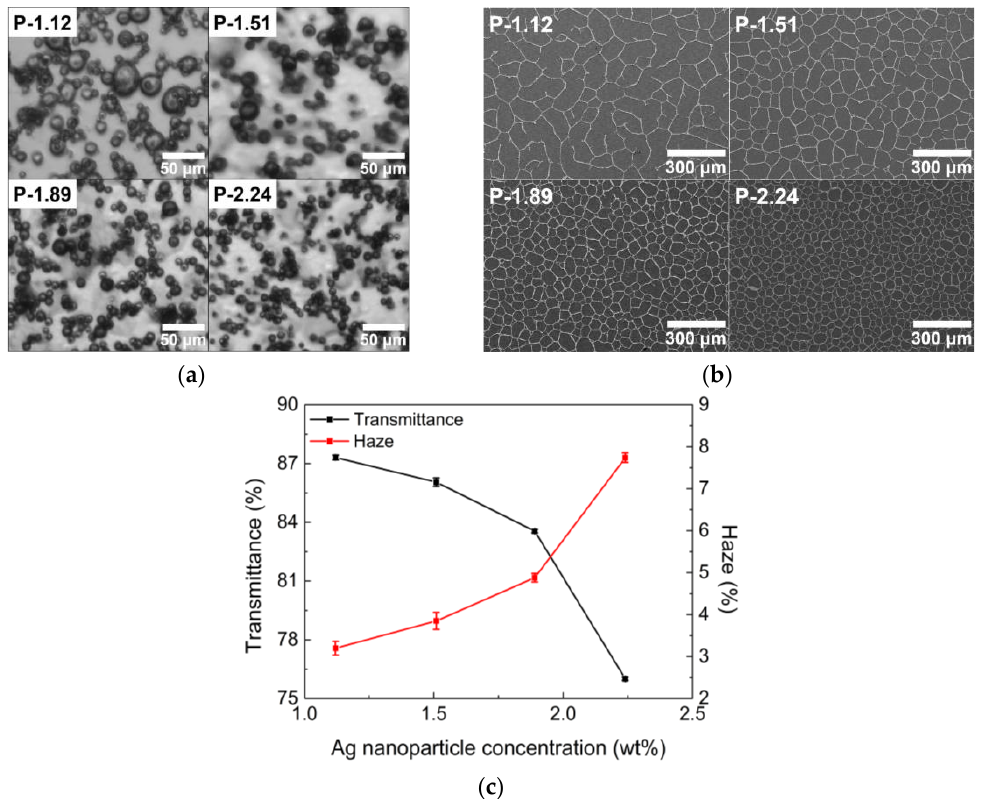
Figure 2. ( a ) Optical images of droplets in emulsion, ( b ) SEM images of TCFs, and ( c ) optical prop- erties of TCFs with different concentration of AgNPs.